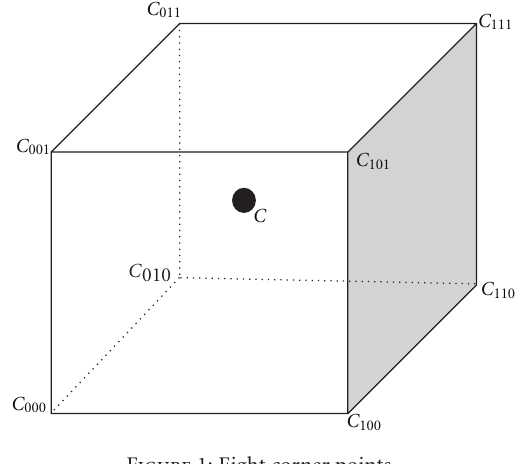
Figure 1: Eight corner points.